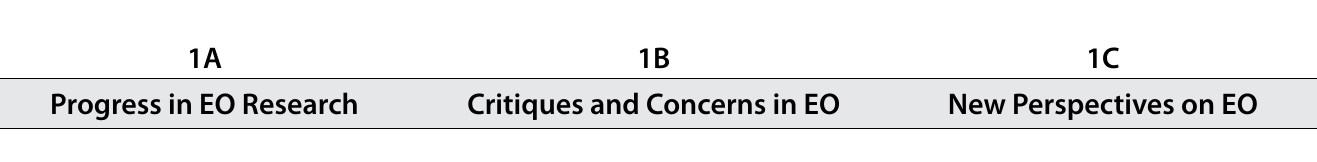
Table 1: Key Contributions in EO